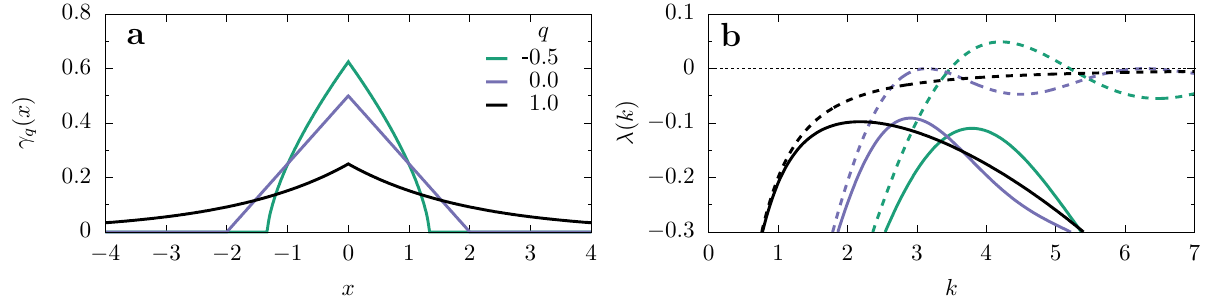
Figure 2. Interaction kernel and mode stability in a homogeneous medium. ( a ) γ q ( x ) , defined in Eq. (4), for 2 . ( b ) Mode growth rate (cid:31) ( k ) given by Eq. (5), for a the values of q indicated on the figure, and ℓ = 0 (dashed lines) and D 0.01 (solid lines), corresponding to the values of q plotted in ( a ). The case with D = = 0 (triangular kernel) is the critical one, for which the maximal value of (cid:31) ( k ) at finite k is zero when D q = Notice that, when diffusion is absent, the mode growth rate is proportional to the kernel Fourier transform (see Eq.